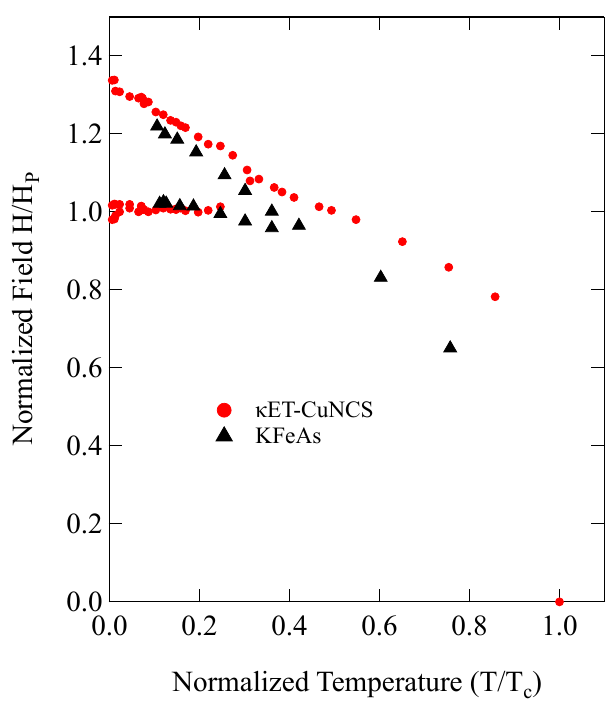
Figure 10. Color online. The phase diagram of κ ET-CuNCS superimposed with the KFe 2 As 2 data from Cho et al. [107], normalized to T c and H P for each sample respectively. We note the two main differences, the slope of the vortex-FFLO transition, and the overall enhancement of the FFLO state over H P